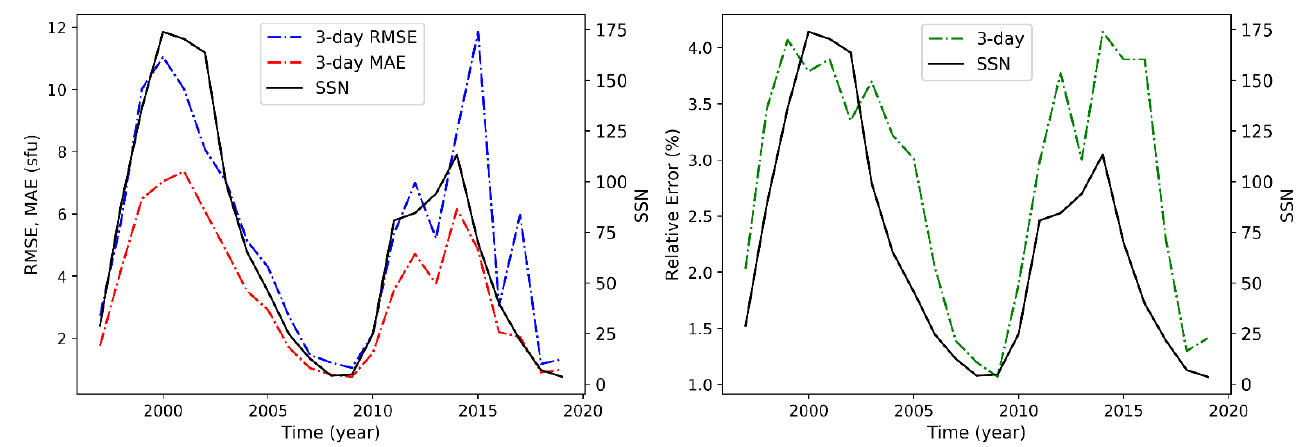
Figure 7. Annual variations of the prediction error and SSN.